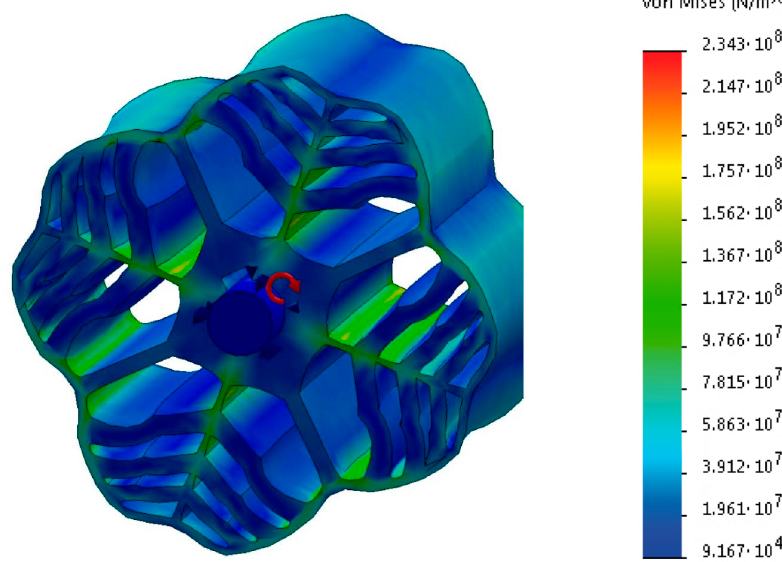
Figure 5. Pattern of distribution of mechanical stresses under the action of centrifugal forces.